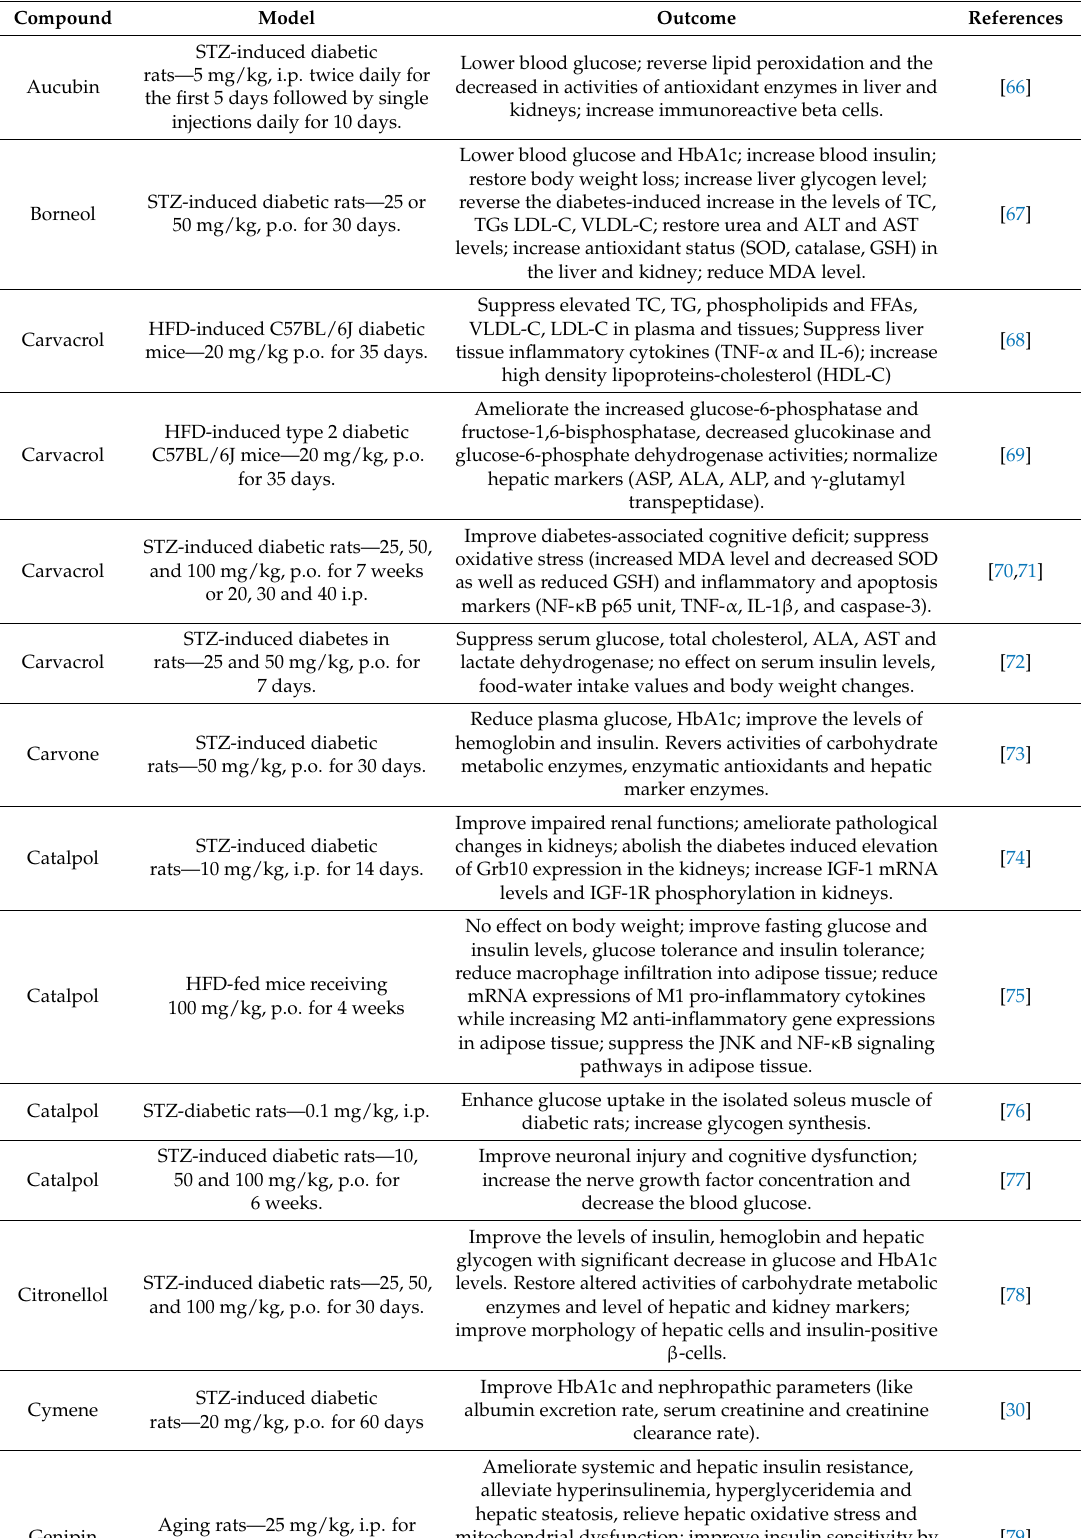
Table 2. In vivo antidiabetic effects of